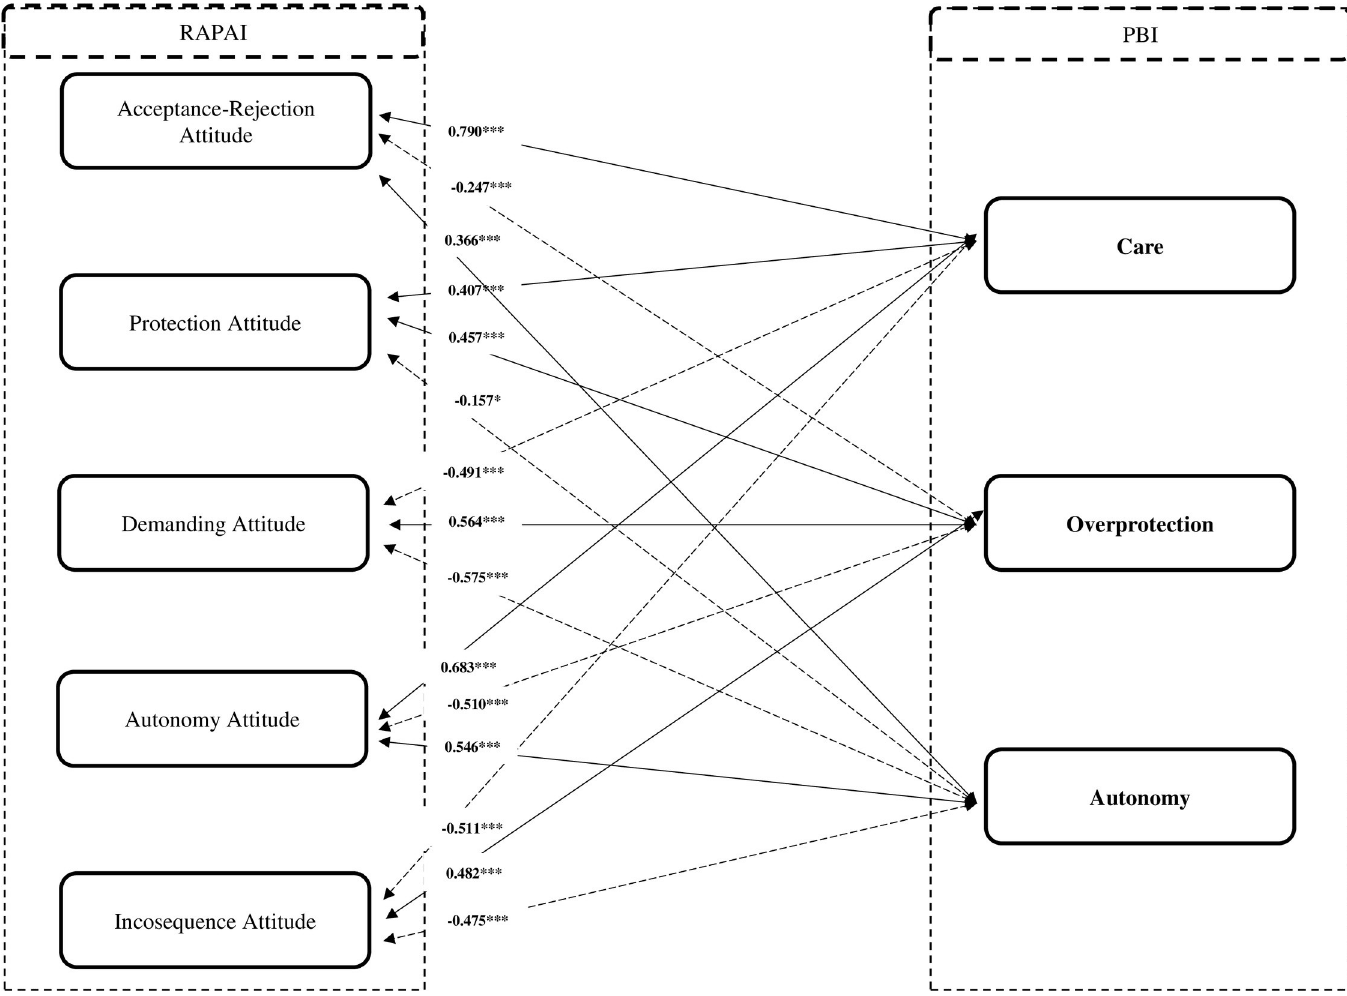
Fig 3. Correlation analysis for PBI dimensions and RAPAI dimensions for father. Note: PBI–Parental Bonding Instrument; RAPAI: Retrospective Assessment of Parents’ Attitudes Inventory; � p < 0.05; ��� p <